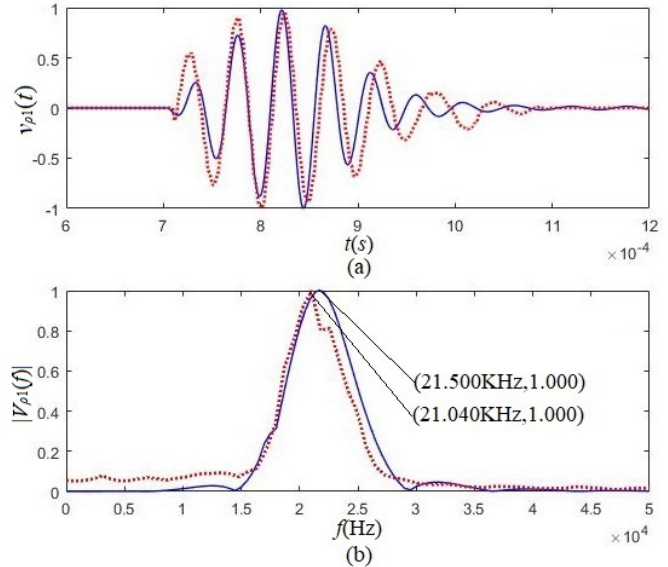
Figure 12. The system’s calculated waveforms and amplitude spectrum and measurements consist of two tangentially polarized transducers. The solid lines are theory calculation results, and the dotted lines are experiment measurements. ( a ) Waveforms; ( b ) amplitude